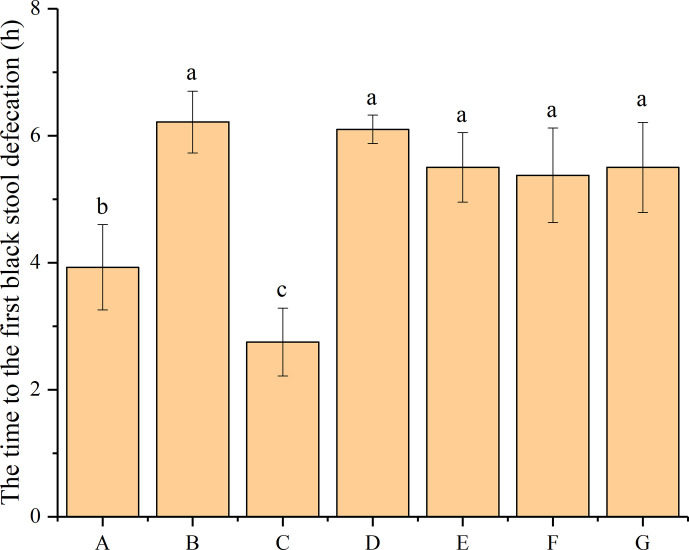
Time to the first black-stool defecation in BALB/c mice after constipation had been induced by loperamide hydrochloride and different treatments were given (n = 10). (A) Normal control: no treatment; (B) negative control group: physiological saline; (C) positive control group: phenolphthalein (70 mg/kg body weight); (D) treatment group: P. acidilactici CCFM28 strain; (E) treatment group: P. acidilactici CCFM18 strain; (F) treatment group: P. acidilactici NT17-3 strain; (G) treatment group: P. acidilactici 102H8 strain. The letters a, b, and c indicate significant differences (P < 0.05) as determined using Duncan’s multiple range test.